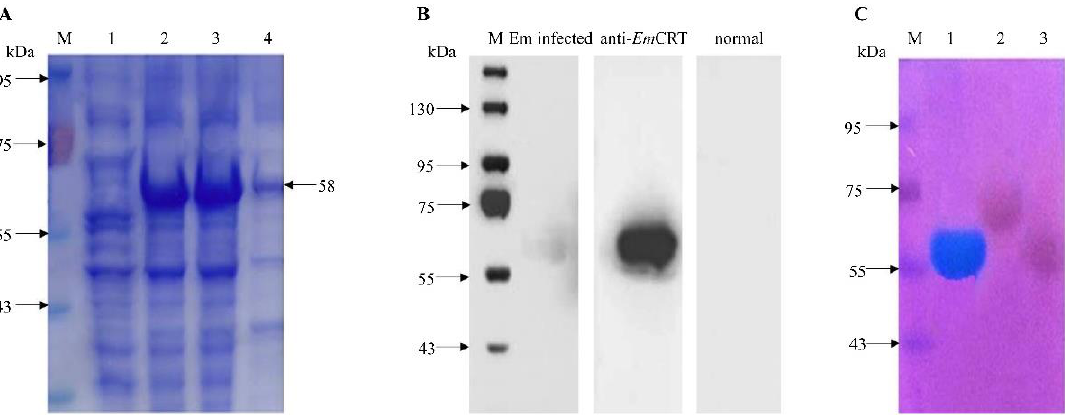
Figure 2. Expression and characterization of r Em CRT. ( A ) Expression of r Em CRT in E. coli BL21 as soluble protein. After being induced with 0.4 mM IPTG for 4 h, the soluble fraction of induced (lane 3) or the whole induced lysate (lane 2) compared with lysate without induction (lane 1). Lane 4, purified r Em CRT (2 ug). ( B ) Recognition of r Em CRT by specific antibodies. Western blot analysis of r Em CRT (500 ng) with E. multilocularis -infected mouse sera, anti-r Em CRT mouse sera and with normal mouse sera. ( C ) Purified r Em CRT and other control proteins (100 ug each) stained with Stains-all. Lane 1, r Em CRT stained in blue; Lane 2, r Em Bmi-1-GST as a E. multilocularis irrelevant protein control; and Lane 3, BSA control stained in red. M, molecular weight marker.